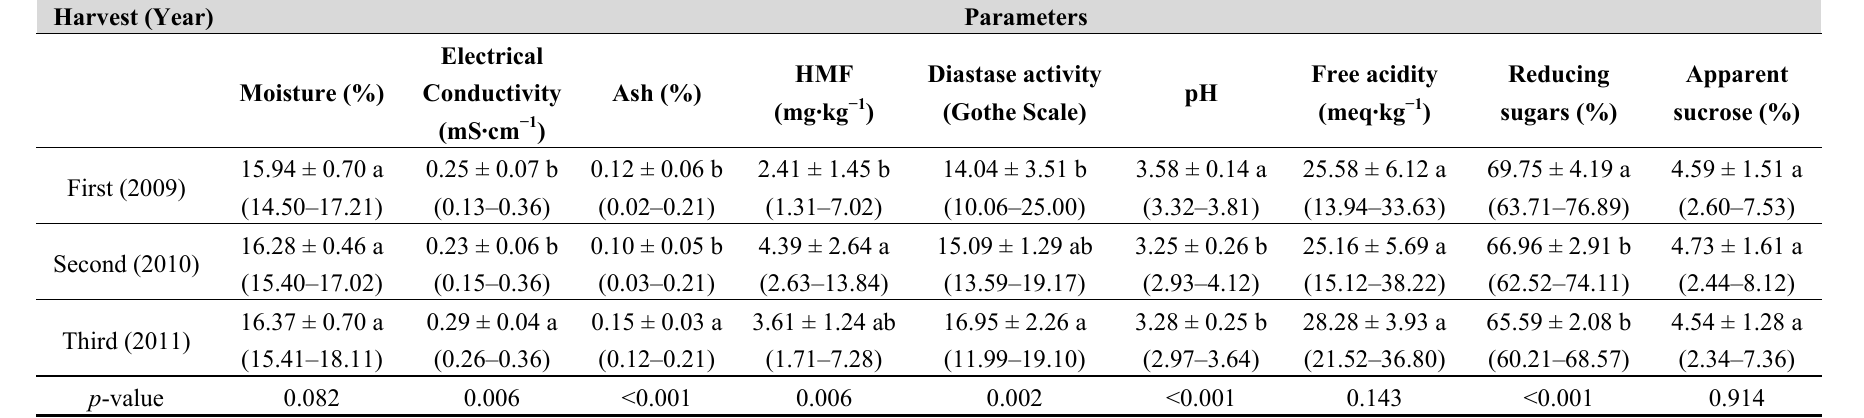
Table 1. Physicochemical results of “Terra Quente” honeys from the three